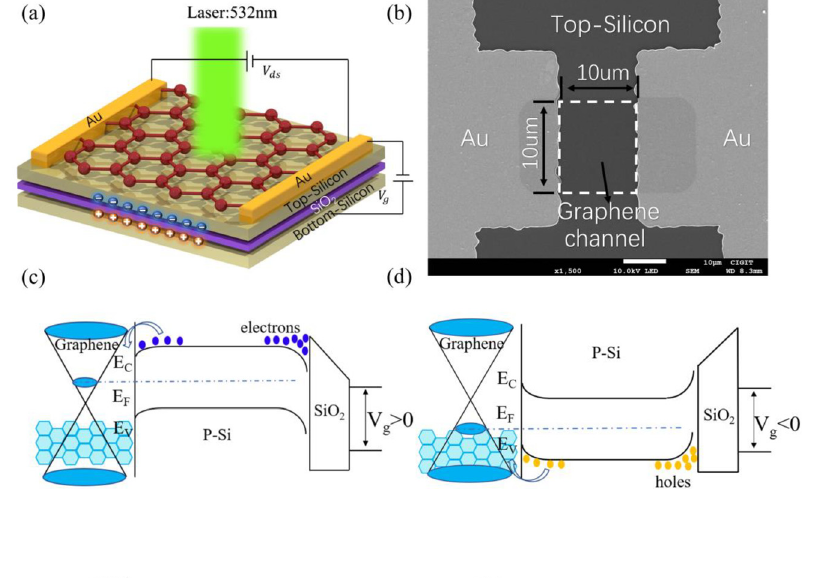
Figure 2: (a) Relationship of source-drain current ( I ds ) with source-drain voltage ( V ds ) under different V g in the dark state. The insetshowsthecurvedetailsof V g =10,30, and 60 V . (b) I ds as a function of the vertical voltage underdifferent opticalpowers.The inset shows the curve details around the “ in fl ection point ” . (c) Time-dependent photoresponse to the periodic chopping of the light source when V g = 0, 30, and 60 V. The yellow and white region corresponds to the light-adding and non-light period, respectively. The illumination power is 920 µw. (d) Responsivity and photocurrent versus different optical power when V g =